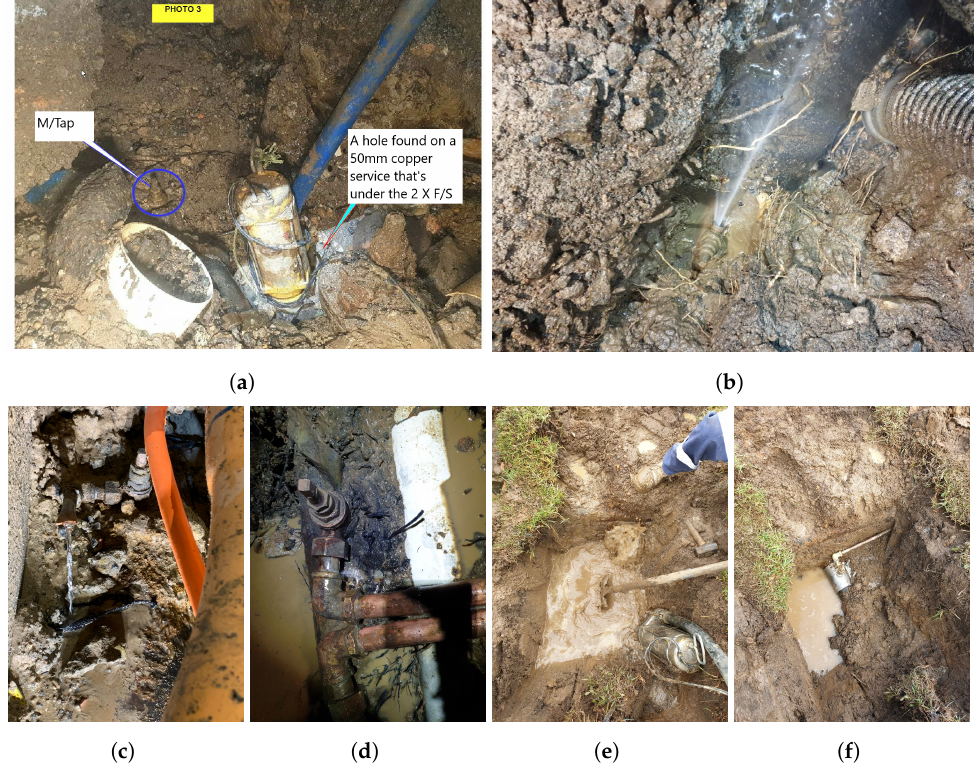
Figure 3. Examples of detected hidden leaks from a range of vibro-acoustic sensors and deployment areas (pictures supplied by utility field crews, taken during repairs): ( a ) Copper service leak, ( b ) Main tap leak, ( c ) Main tap leak (clamped service line), ( d ) Leak on main tap coupling piece, ( e )